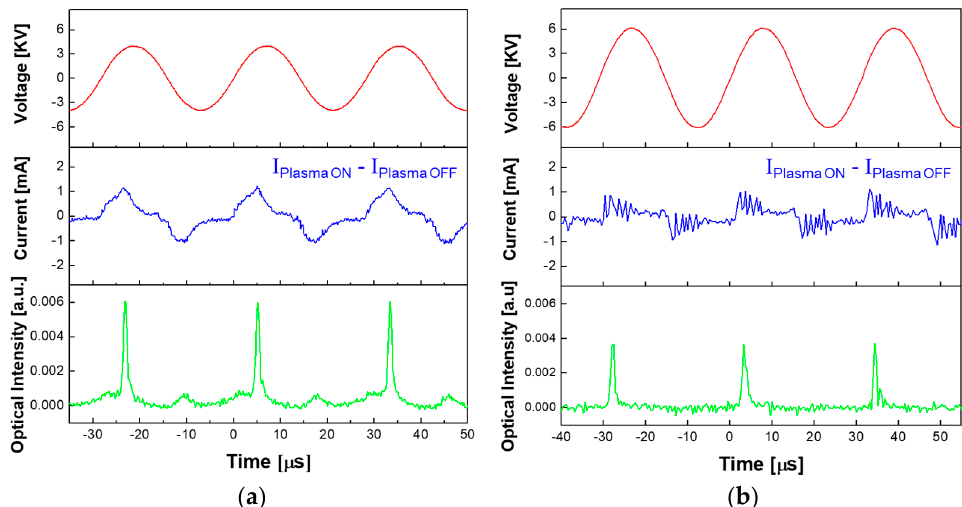
Figure 2. The temporal characteristics of driving voltage, discharge current, and optical emission from the plasmas produced using ( a ) the newly designed AP-plasma reactor, and ( b ) the previously reported APPJ array. The discharge current waveform was obtained by subtracting the displacement current waveform from the total current